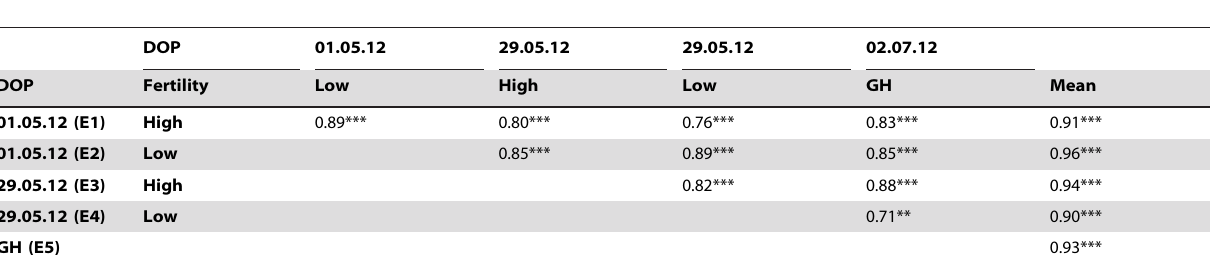
Table 4. Correlation matrix of rankings of mean SPAD readings over dates in Experiment 2 for all genotypes and environments (E1–E4) in the field arising from combination of 2 planting dates (DOP) and 2 fertility levels (Low and High) and in the glasshouse (GH) as the fifth environment